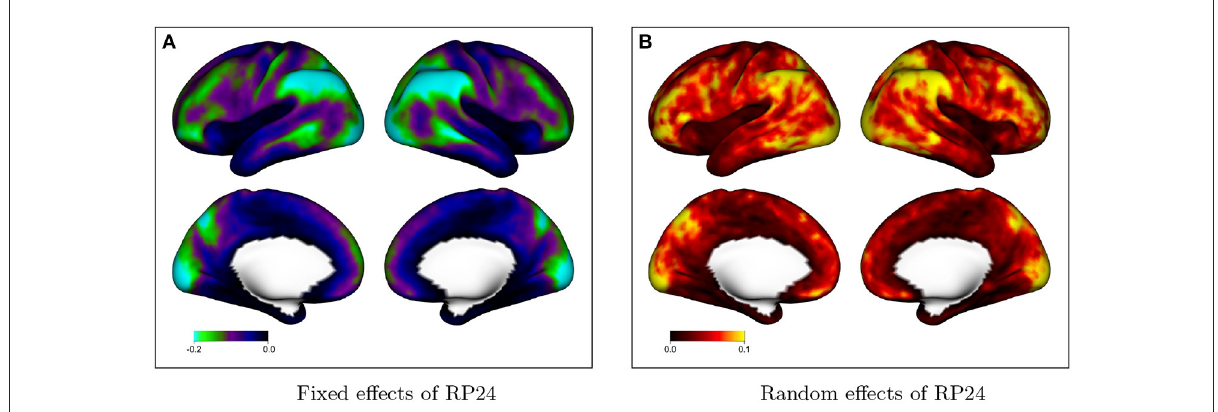
FIGURE4 Effect of including additional motion regressors on autocorrelation index (ACI), based on the fixed effects in model (2). Values represent the decrease in ACI associated with including 24 rather than 12 motion regressors. (A) The fixed effects at every vertex; (B) shows the random effect standard deviation at every